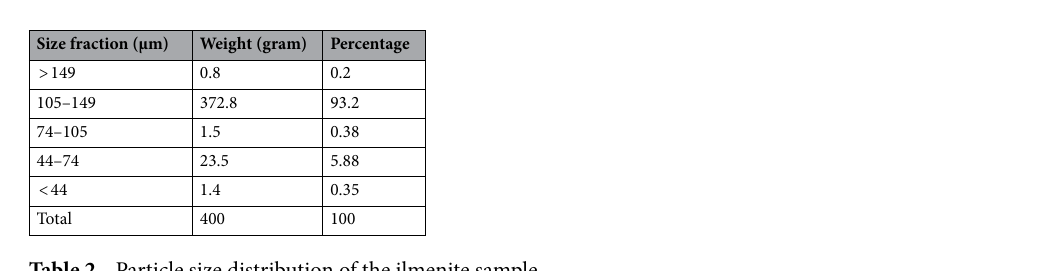
Table 2. Particle size distribution of the ilmenite